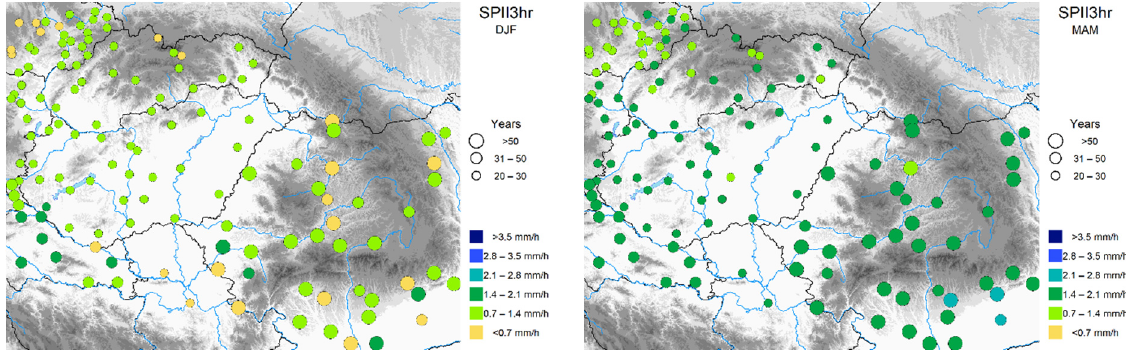
Figure 7. Seasonal averages of the 3-h precipitation intensity (SPII3hr). The circles and their sizes are the same as in Figure 3.